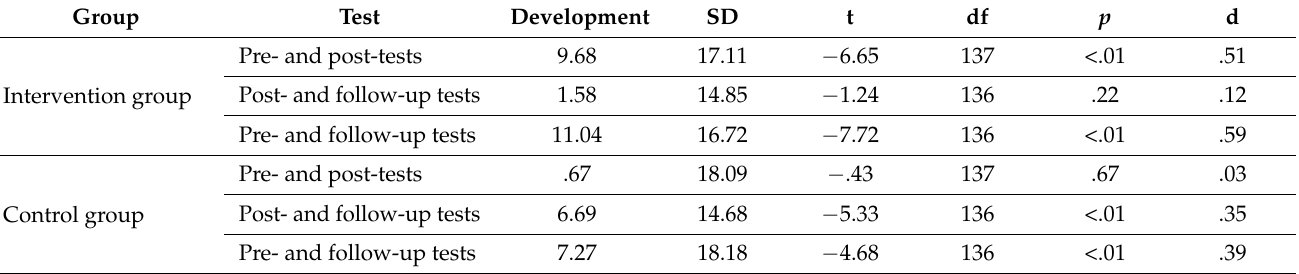
Table 2. The development of the students in the intervention and control groups between the pre-, post-, and follow-up tests in standard deviation units on a manifest